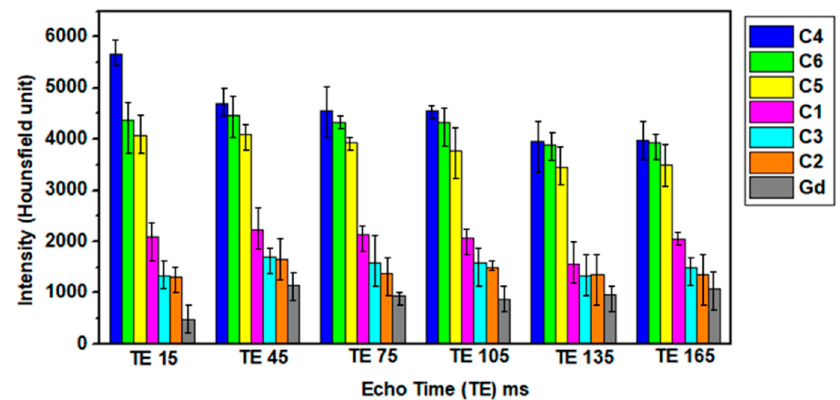
Figure 6. T2 intensities of magnetic nanoparticles samples for two concentrations of sample 1, sample 3 and Gd.